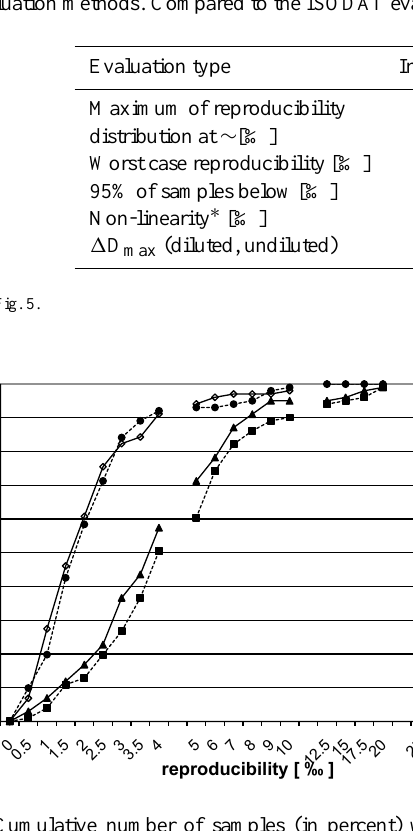
Table 1. Reproducibilities obtained for several evaluation methods. The SPI-type evaluation results in the lowest deviation from the linearity of all evaluation methods. Compared to the ISODAT evaluations SPI improves the overall and the individual reproducibility.